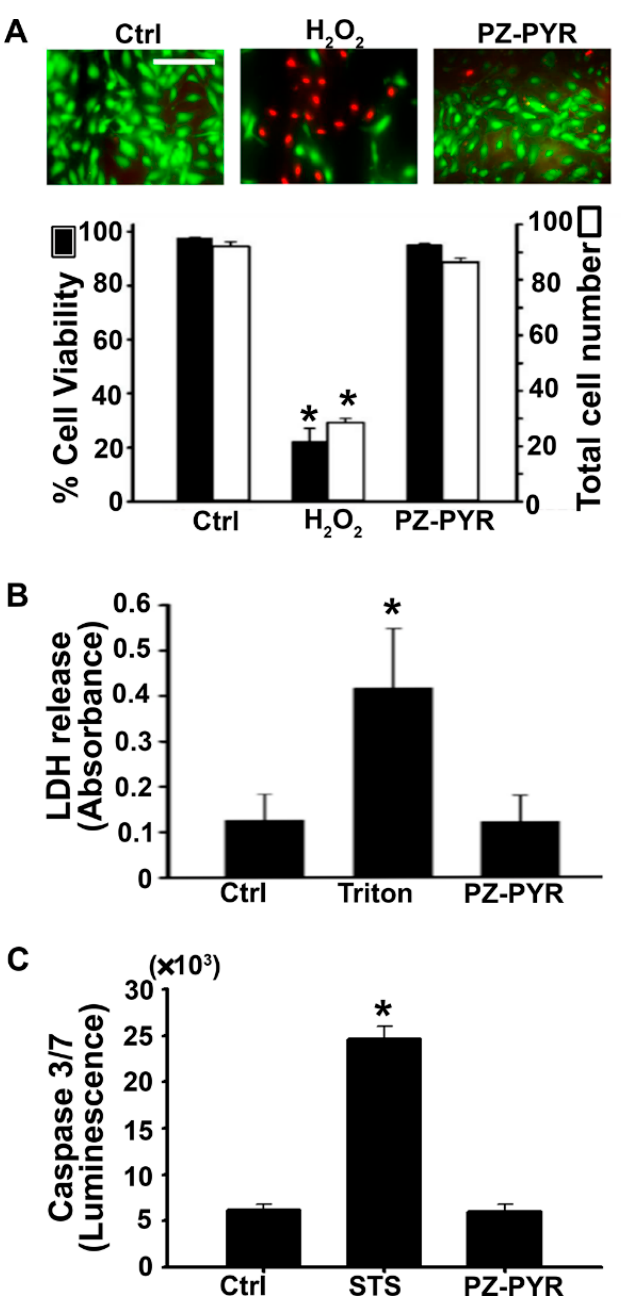
Figure 7. Cytotoxicity of polyphosphazene polymers. ( A ) HUVECs were treated with regular medium (Ctrl), 5 mM hydrogen peroxide (H 2 O 2 ) to induce cell death, or PZ-PYR for 1 h following which the treatment was removed, and a live-dead viability assay was conducted where live cells appear green whereas dead cells appear red in fluorescent images. Data indicates the mean ± SEM total number of cells per image (white bars) as well as the % viability expressed as the percentage of live cells among the total cells (black bars). Scale bar = 50 µ m. ( B ) HUVECs were incubated with regular medium (Ctrl), 0.1% triton to permeabilize cell membranes, or PZ-PYR for 1h following which the medium was removed and subjected to measurement of lactate dehydrogenase released into the medium. Data expressed as mean ± SEM of absorbance at 490 nm. ( C ) HUVECs were incubated with regular medium (Ctrl), 1 µ M staurosporine (STS) to induce apoptosis, or PZ-PYR for 1 h following which the Caspase 3/7 in the cell + medium fraction was determined. Data expressed as mean ± SEM of luminescence. * p < 0.05 relative to the untreated